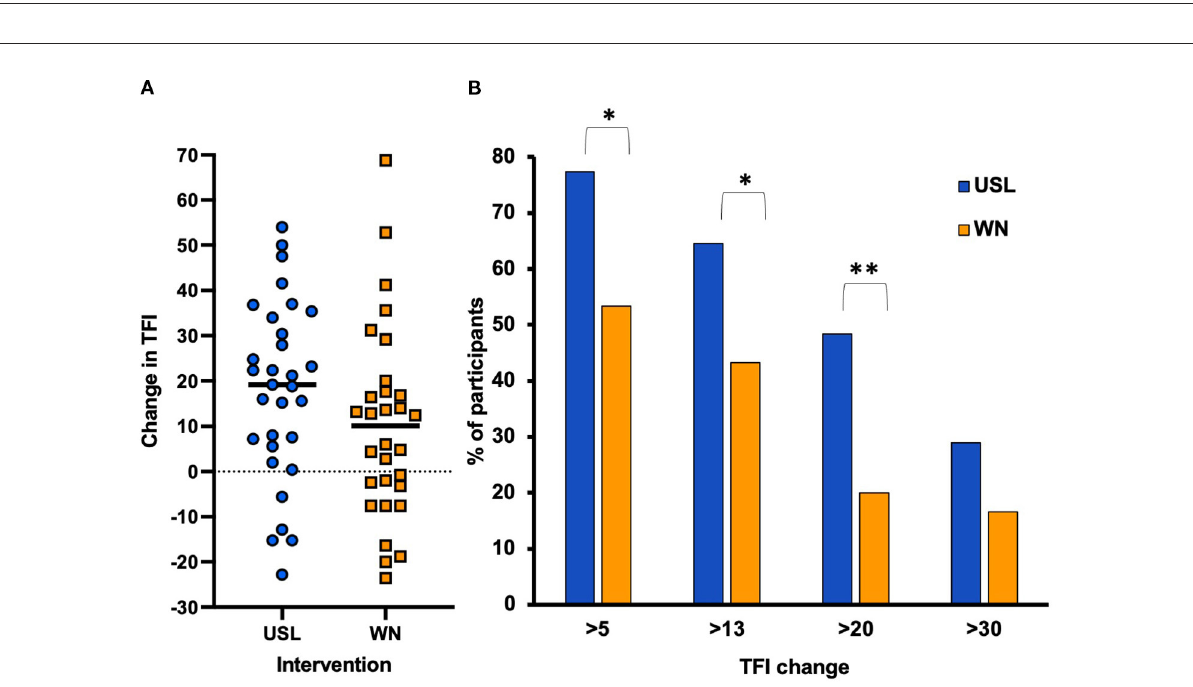
FIGURE4 (A) Change in TFI total score between baseline and 12 weeks for each group. The horizontal line indicates average TFI change for each group. (B) Responder analysis. The proportion of the two groups with reduced TFI of ( > 5, 13, 20, and 30 points) at 12 weeks of trial ( * P < 0.05, ** P < 0.01). A change of > 13 points is considered clinically